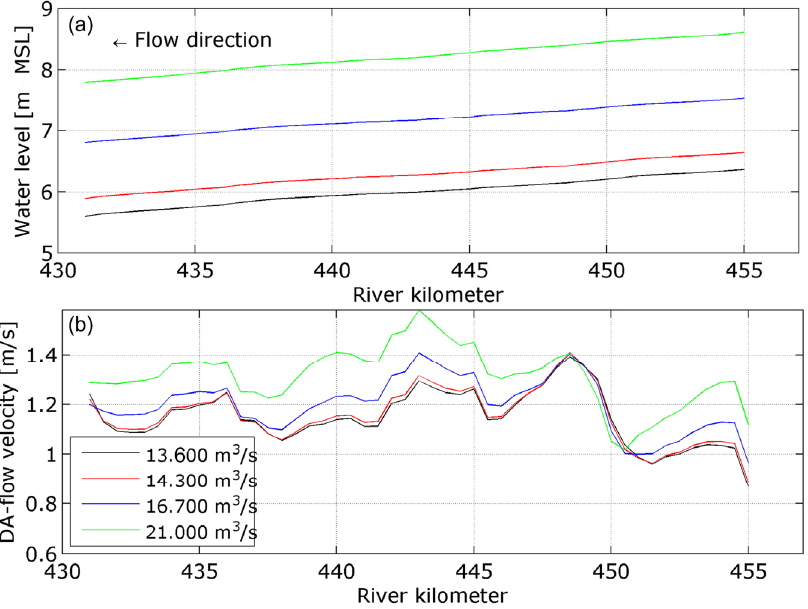
Figure 5. ( a ) Water levels and ( b ) Depth-averaged (DA) flow velocities at four different discharge